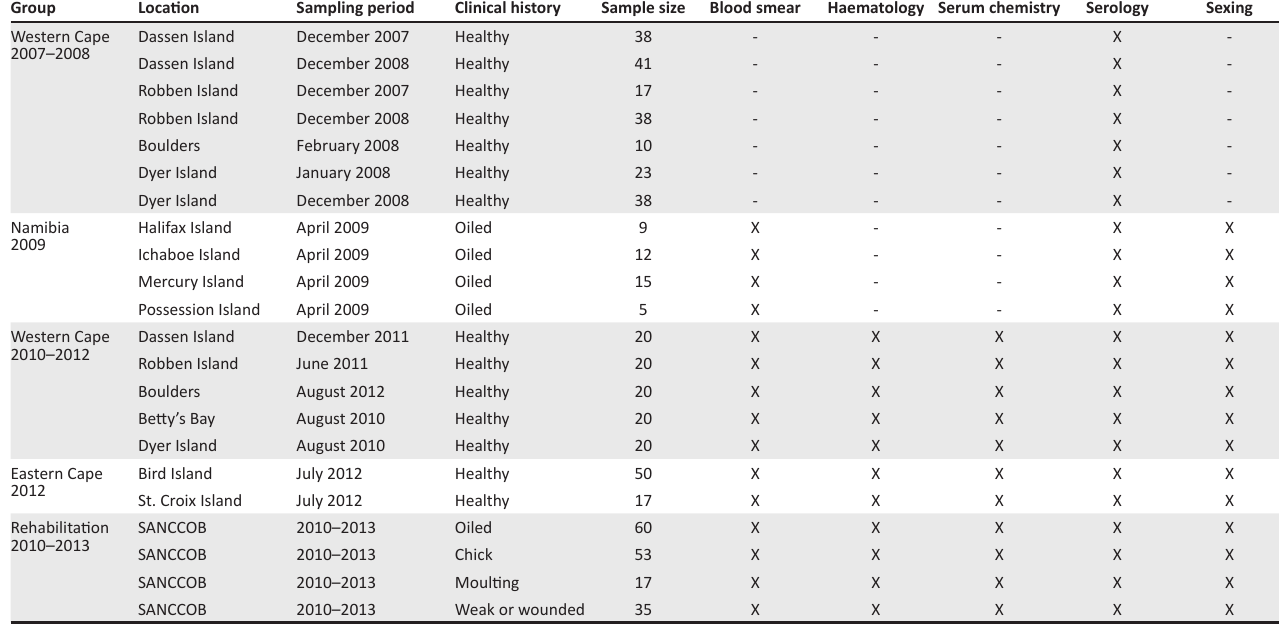
TABLE 1: Summary of the sampling effort and tests evaluated during this health assessment of African penguins.